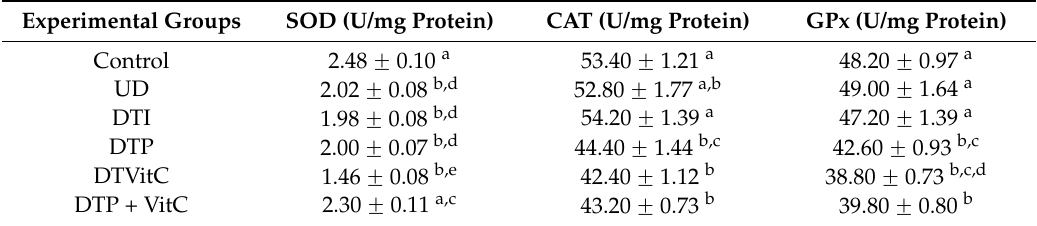
Table 3. Effects of treatment with insulin, probiotic and vitamin C on the activities of brain antioxidant enzymes of alloxan ‐ induced diabetic rats.